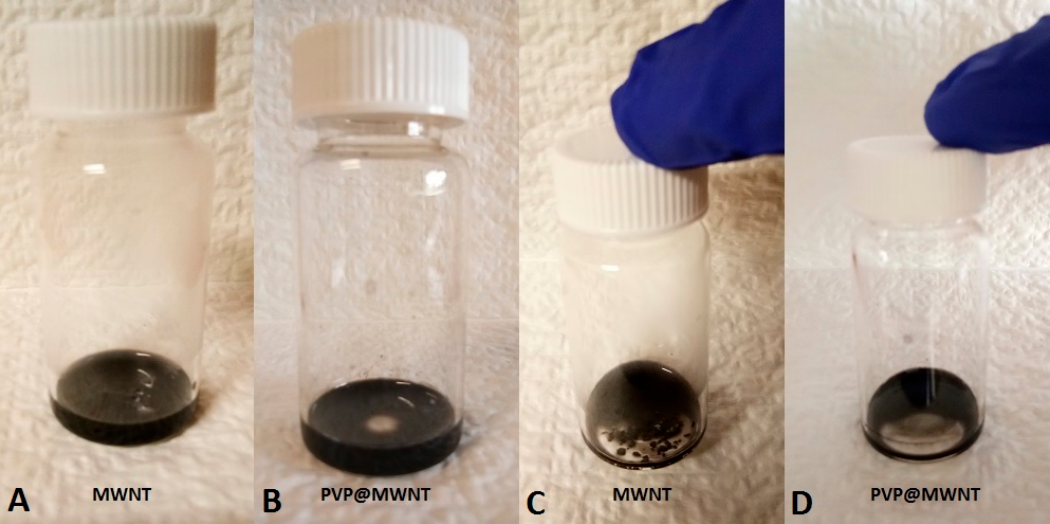
Figure 2. Optical image showing dispersion of MWNT and PVP treated MWNT in DMF: After being treated with sonication ( A , B ) and after being statically placed for 120 h ( C ) and 240 h ( D ).